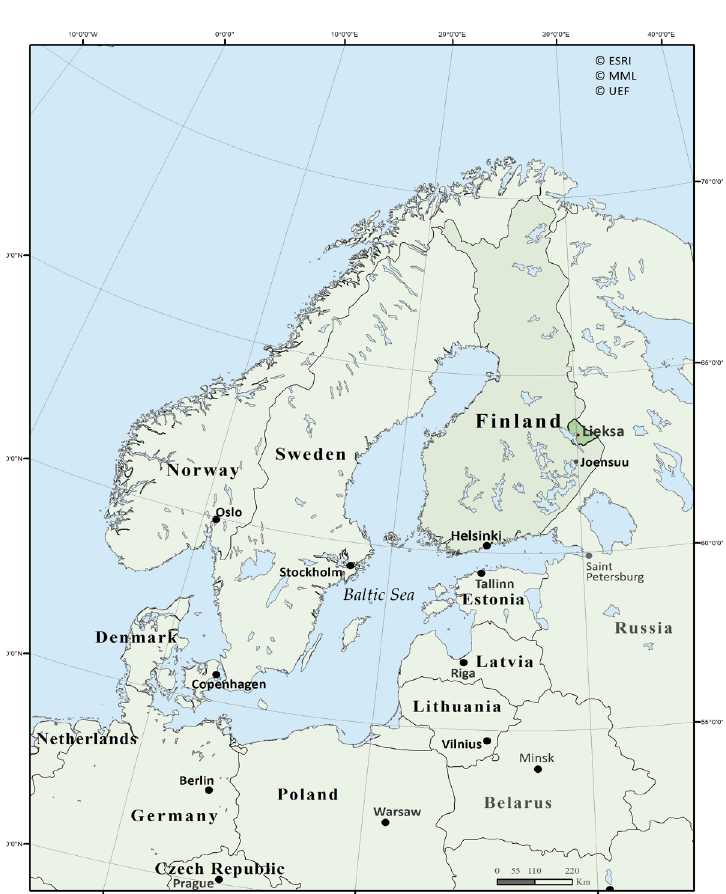
Fig. 1. Lieksa as a distant periphery from the regional centre Joensuu (ca. 100 km) and capital city Helsinki (ca. 500